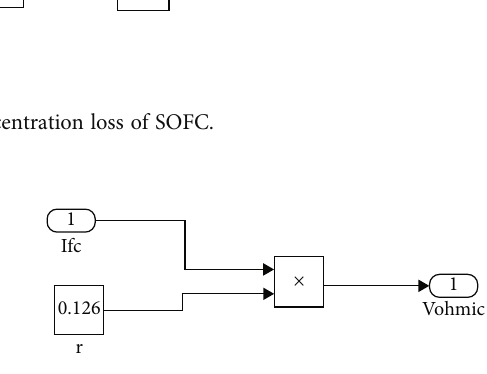
Figure 13: Simulink model for ohmic loss of SOFC.